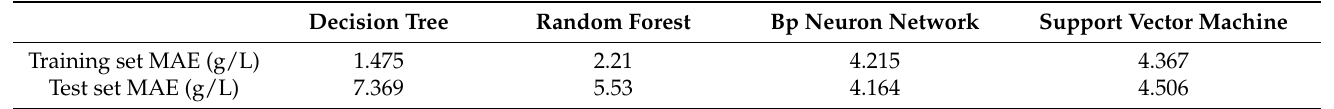
Table 4. The mean absolute error (MAE) of using different substrate addition values to predict final PMLA production by four machine learning methods.